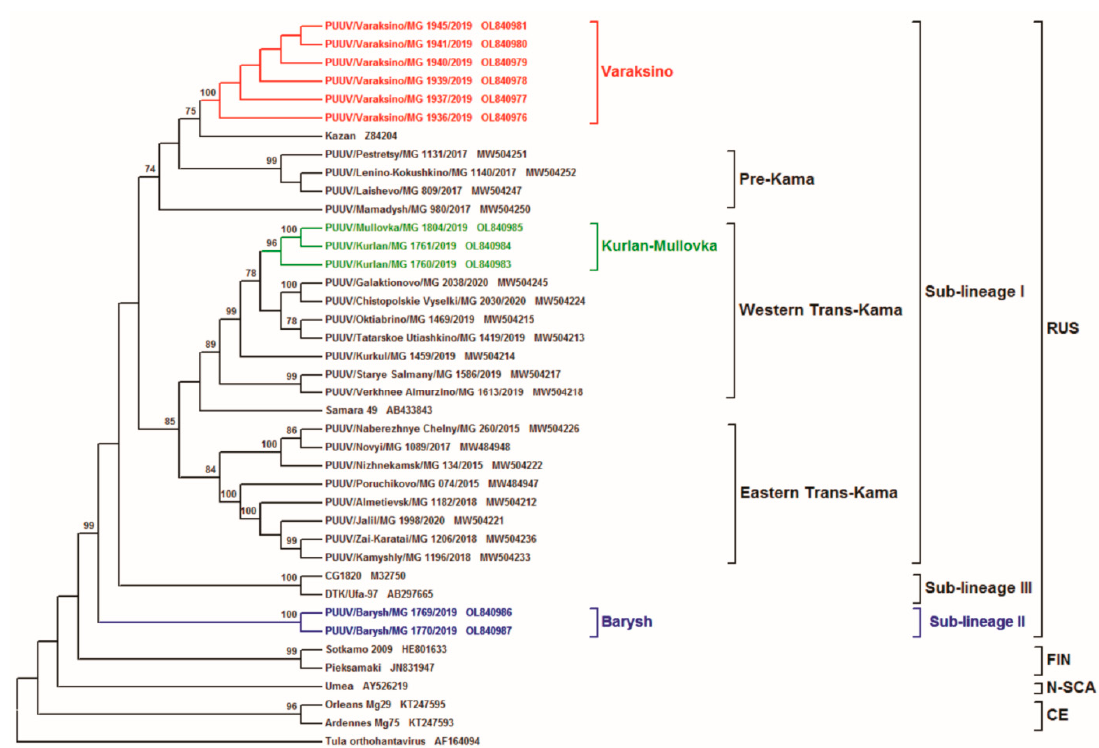
Figure 2. Phylogenetic tree calculated based on the complete coding region (CDS) (1302 bp) of PUUV S segment sequences obtained from bank voles trapped in ULR and UR. The sequence position was aligned against GenBank PUUUV Kazan strain, accession number Z84204.